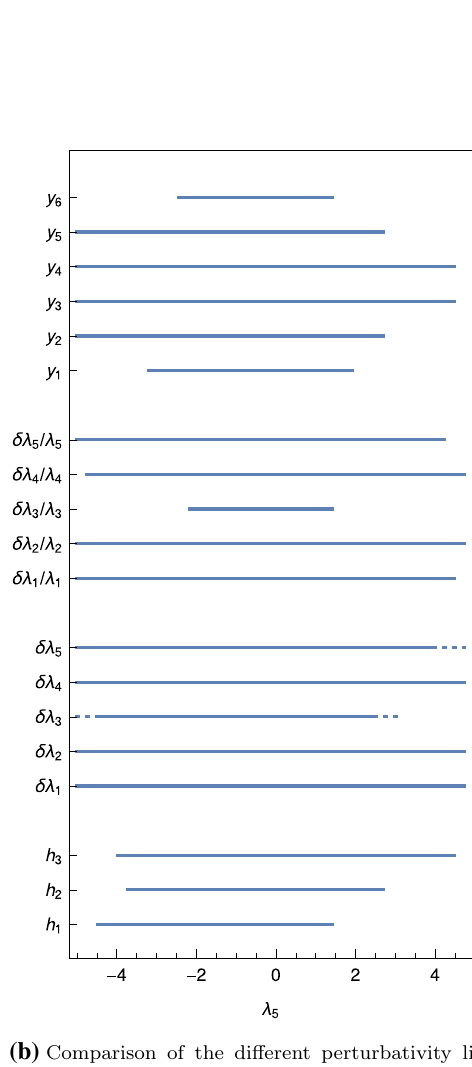
(b) Comparison of the different perturbativity limits. See Fig. 4 for more details.